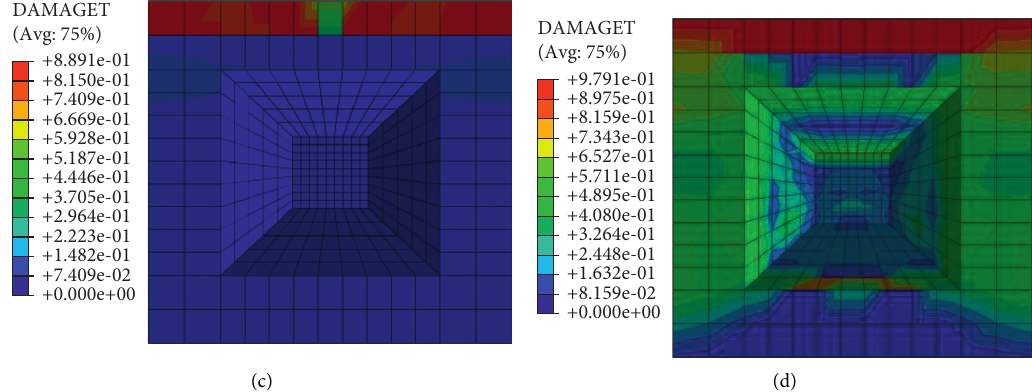
Figure 20: Cracking patterns of Type 3. (a) Initial interface cracking. (b) Cracking patterns at failure. (c) State of the shear key at initial interface cracking. (d) State of the shear key in failure of the